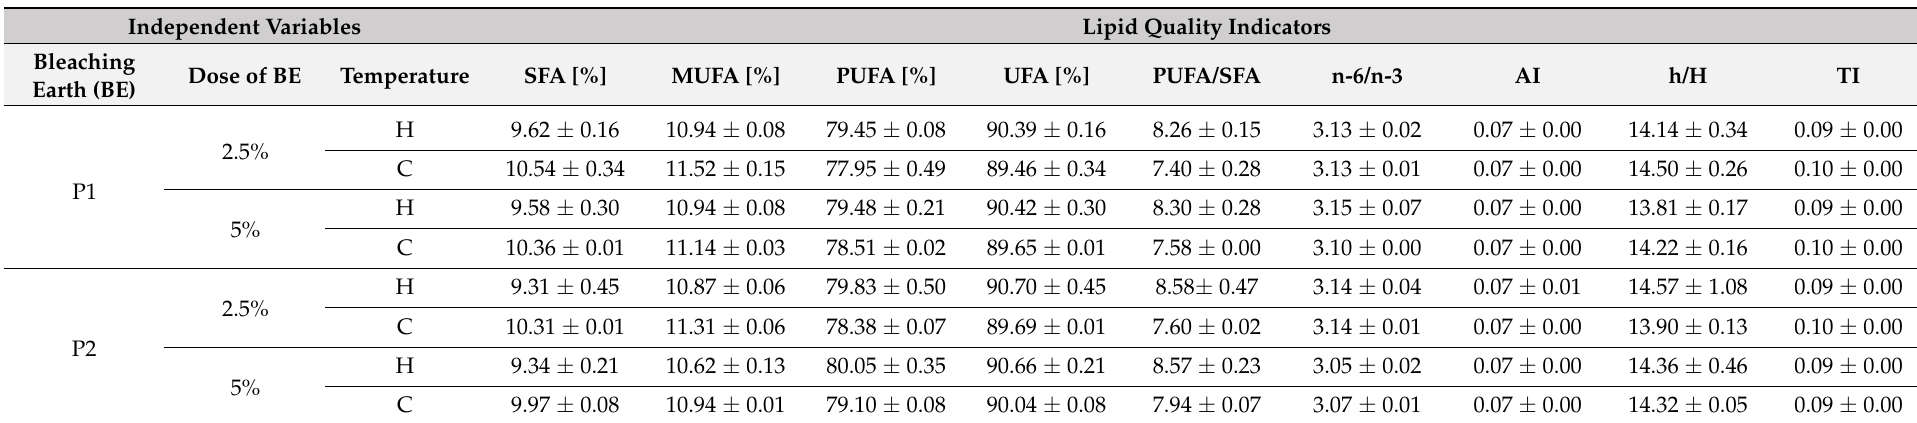
Table A6. Lipid quality indicators of bleaching hemp oil from the ‘Earlina 8FC’